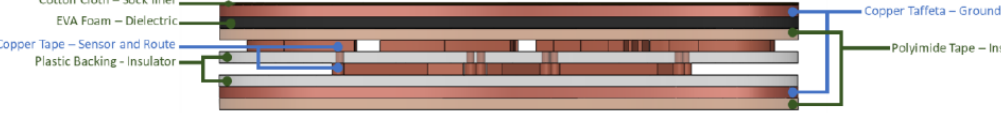
Figure 7. Side View and Layers used for the sensor.